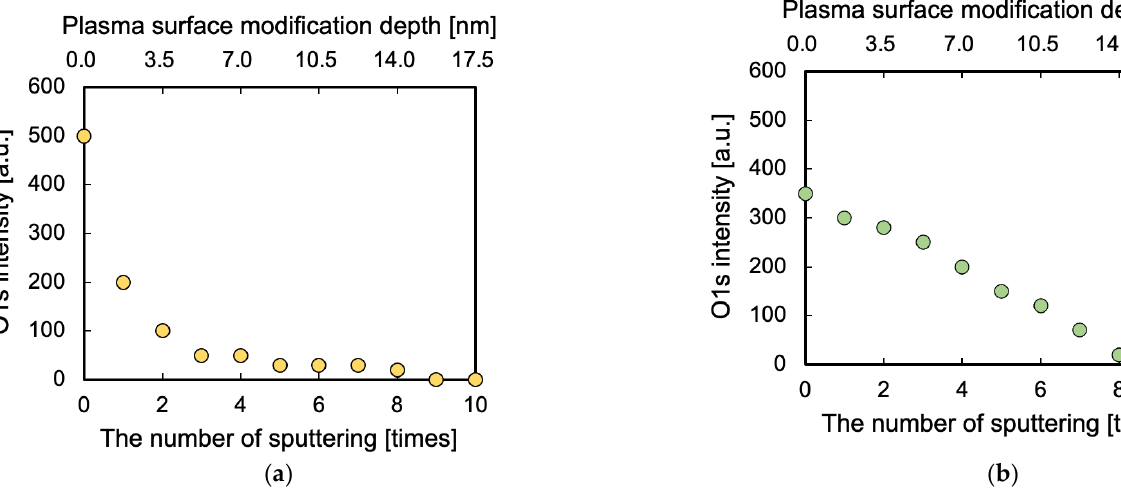
Figure 5. Change in the O1s-XPS peak intensity with increasing the number of sputtering for the PTFE samples HAP-treated using He or Ar gas. ( a ) He-HAP-treated PTFE and ( b ) Ar-HAP-treated PTFE. The upper X-axis showing plasma surface modification depth was calculated by multiplying the GCIB sputtering rate (1.75 nm/time = 3.5 nm/min) and the number of sputtering.